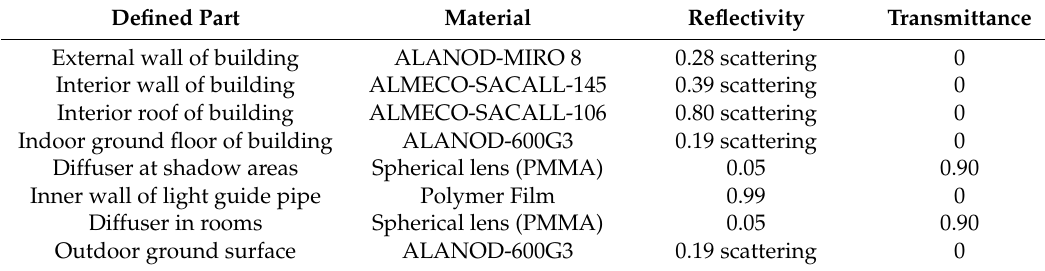
Table 3. Definition of material in each part of the system in TracePro